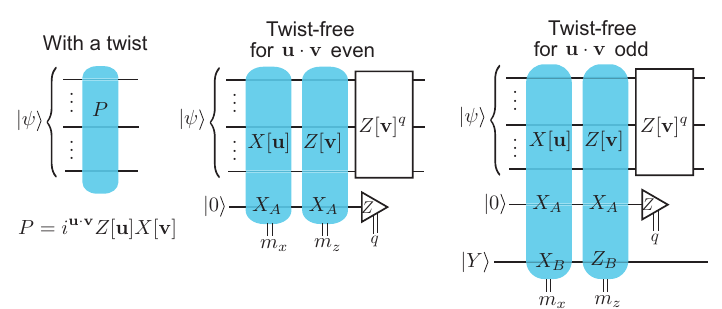
FIG. 10. Implementations of a Pauli measurement of P = i u · v X [ u ] Z [ v ]. Whenever P contains any Y terms, simple lattice-surgery operations cannot be used. The standard solution is to use twist-based lattice surgery. However, we show that the same outcome can be achieved twist free, with an extra | Y (cid:3) ancilla used to handle cases where X [ u ] and Z [ v ] do not com- mute. The twist-free approaches report m x ⊕ m z ⊕ c as the outcome for the measurement of P , where c is a constant determined by u and v .